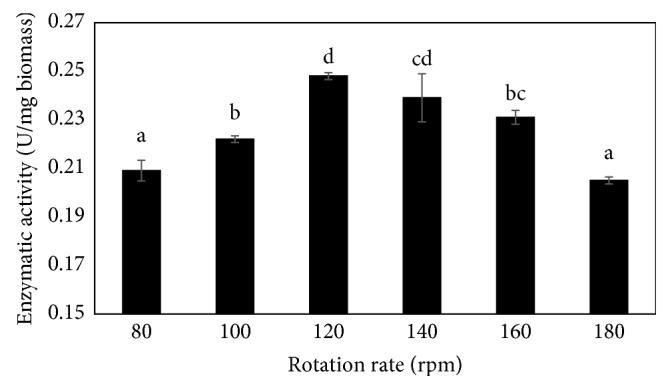
The effect of rotation rate on glucose isomerase production. Rotation rate has close relation with dissolved oxygen and nutrient diffusion in media. When the rotation rate increased from 80 to 120 rpm, the enzyme activity significantly increased (0.209 ± 0.004 and 0.248 ± 0.001 U/mg biomass, resp., p < 0.05). We observed that the faster rotation rate (140–180 rpm) reduced the enzyme activity from 0.239 ± 0.010 to 0.205 ± 0.001 U/mg biomass (p < 0.05). Rotation rate 120 rpm was chosen as the optimal rotation rate for production of glucose isomerase. a, b, c, and d indicate the significant difference between groups.